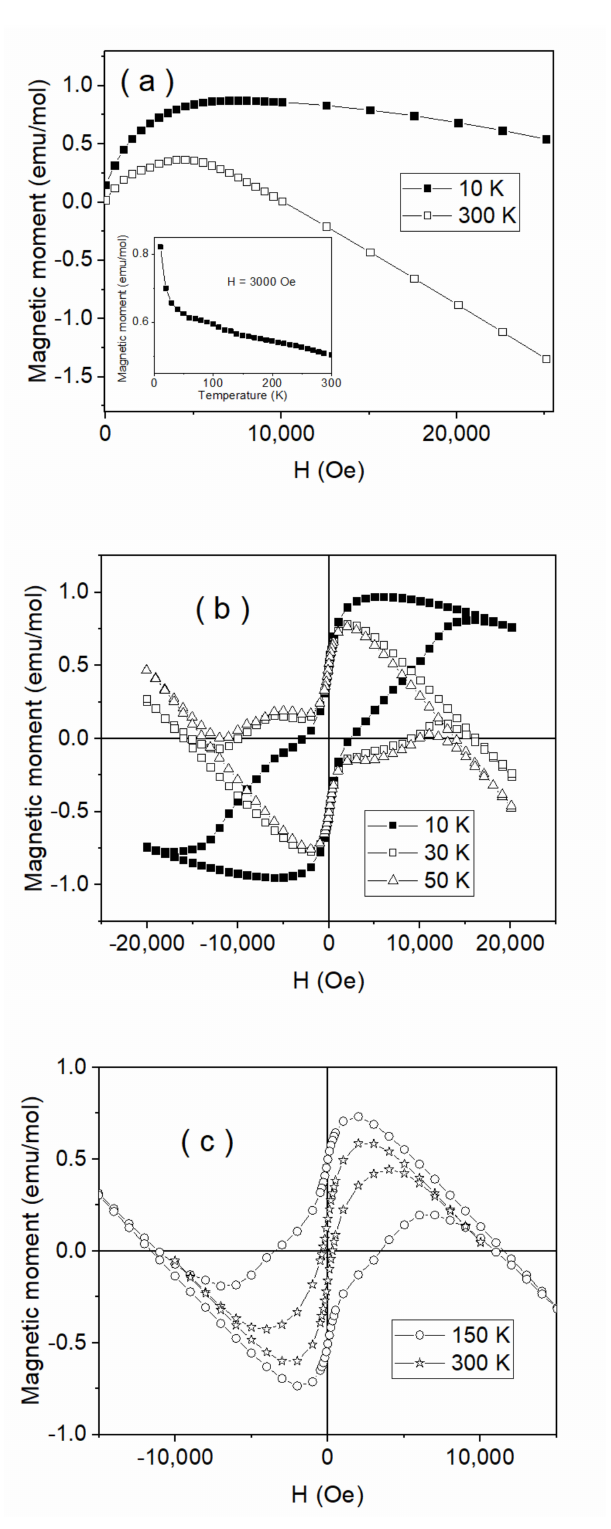
Figure 8. Magnetization data vs. the applied field at 2 di ff erent temperatures ( a ) with the inset presenting the dependence of magnetization vs. temperature in a field of 3,000 Oe and hysteresis loops at 10 K, 30 K and 50 K ( b ) and at higher temperatures up to 300 K ( c